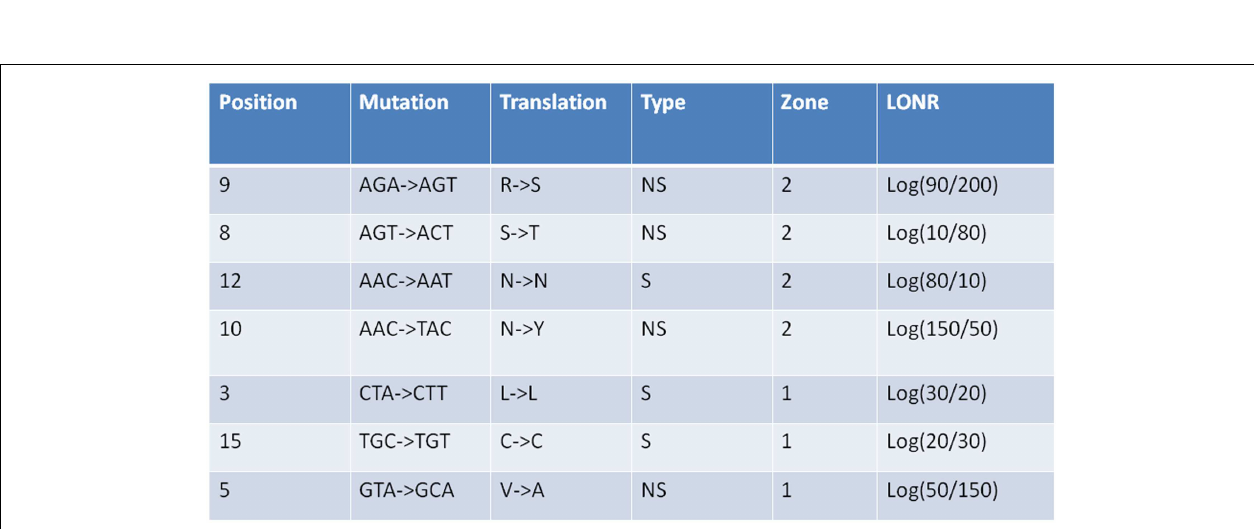
FIGUREA1 |Typical tree with the sequences in each node and the total number of offspring of each node . Only internal nodes are drawn here (leaves are not used for the analysis, since they have no mutations under them).The sequences are divided into two regions (different colors).The number in each node is the total number of offspring.